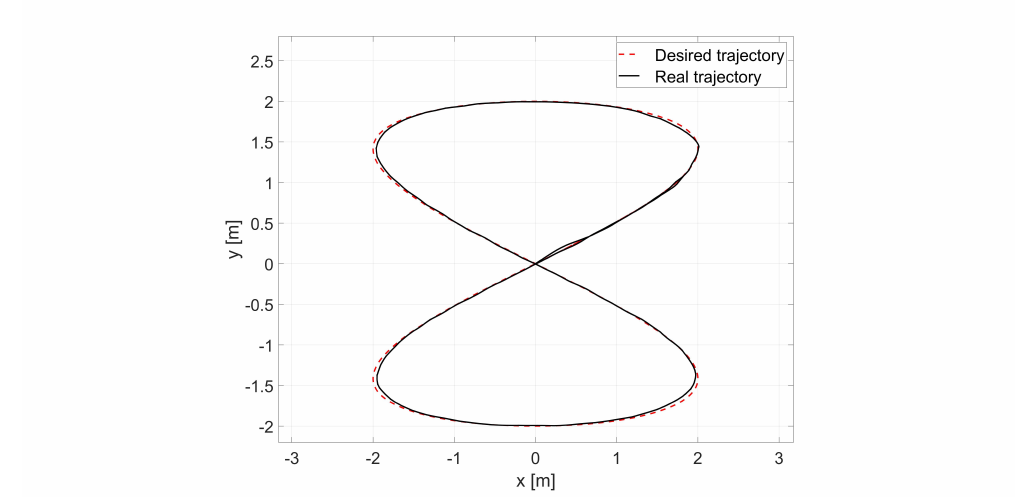
Figure 18. Comparison of reference and real trajectories in a laboratory test of RLS identification with random values of initial parameters.